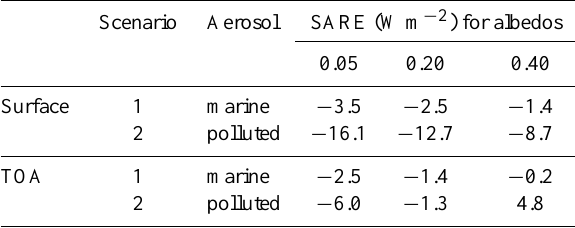
Table 2. Results of radiative-transfer calculations for different sur- face albedos. Pure marine and polluted aerosol conditions were sim- ulated at 0 ◦ latitude and longitude in spring (on 15 April). The set- tings for both scenarios are given in Table 1. TOA and SARE denote the top of the atmosphere and the 24h averaged solar aerosol radia- tive